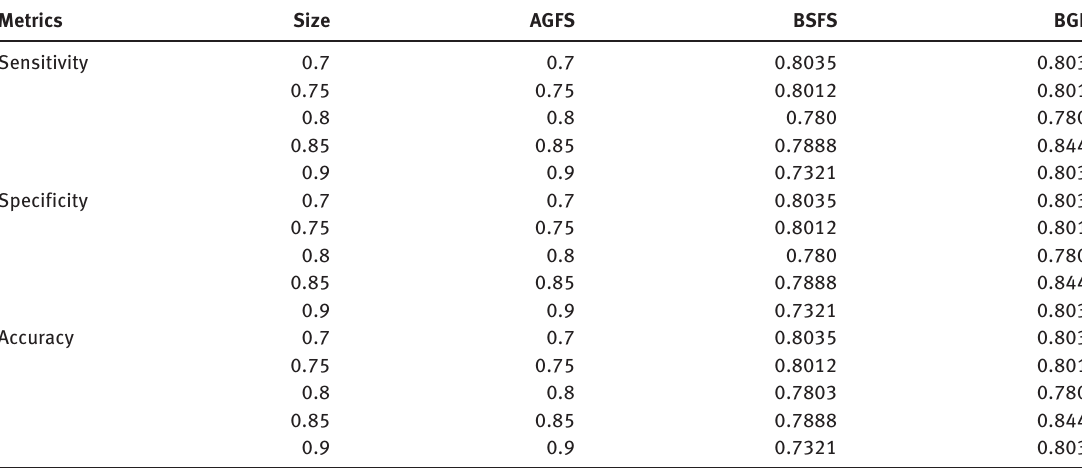
Table 6: Comparison on Lung Cancer